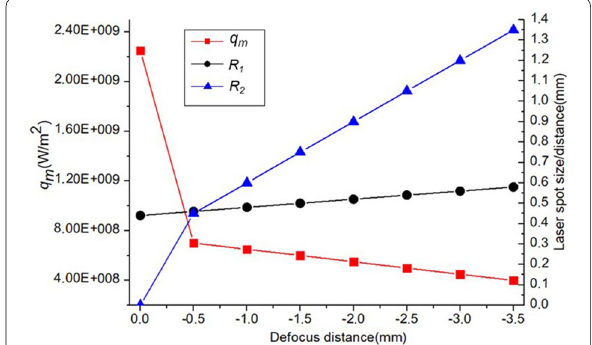
Figure 12 Power intensity and three-beam laser dimensions at various defocus distances calculated by